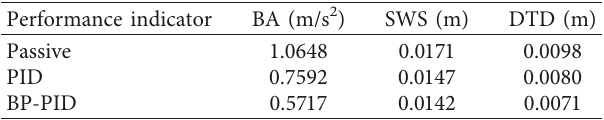
Figure 10: Dynamic tire deflection. Table 2: RMS values of suspension performance indicators of B-class road.